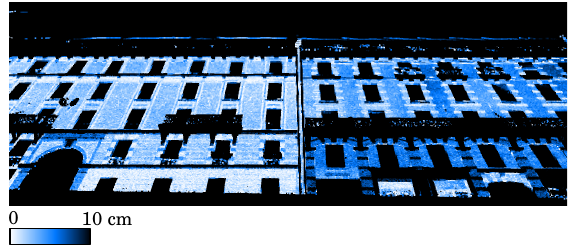
Figure 15: Orthogonal distance to the closest plane. The accuracy of our approach is depending on σ (fig 10). Here, one can see two different facades. They are oriented along the same direction, but they are slightly shifted : the right one is darker. Both have been matched with the same main plane because this shift is lower than 5 σ (equation 1).